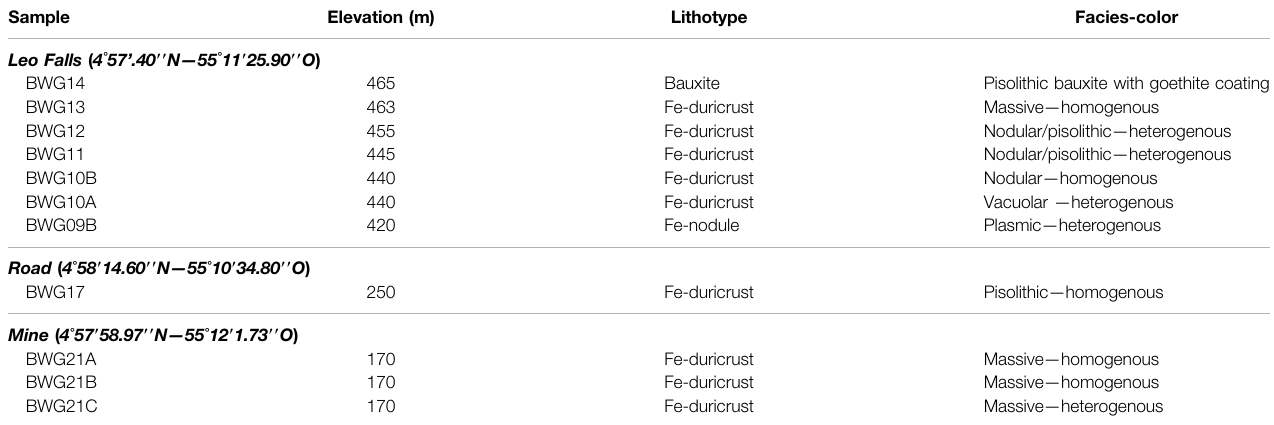
TABLE 1 | Location and elevation of sampling of the different crusts and nodules and main macroscopic characteristics.